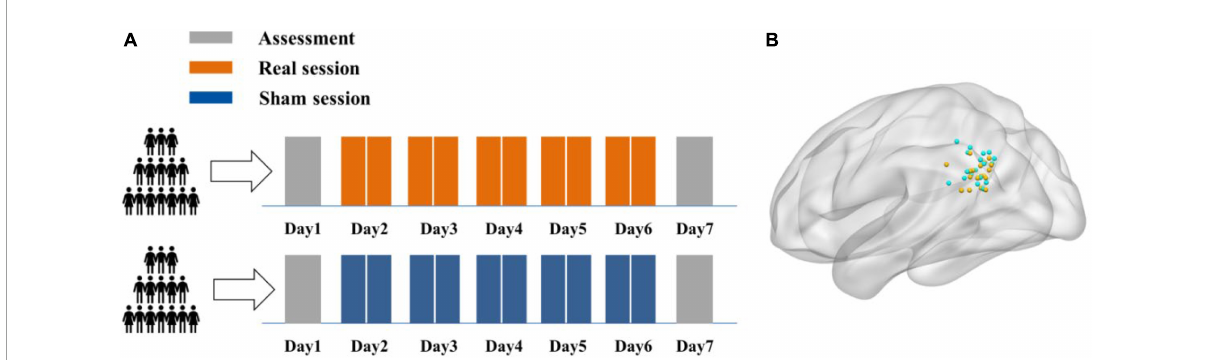
FIGURE1 Experimental design. (A) Each participant received ten real or sham rTMS sessions delivered two per day for five consecutive days. A face-cued recall (associative memory) task and non-associative Stroop task were completed 1 day prior to the first stimulation session (baseline) and 1 day after the final session. (B) The individual stimulation sites in the left IPL were identified by rs-fMRI maps of hippocampal functional connectivity. The stimulation sites for all subjects in real and sham groups are demarcated by green and yellow spheres, respectively, in standard MNI